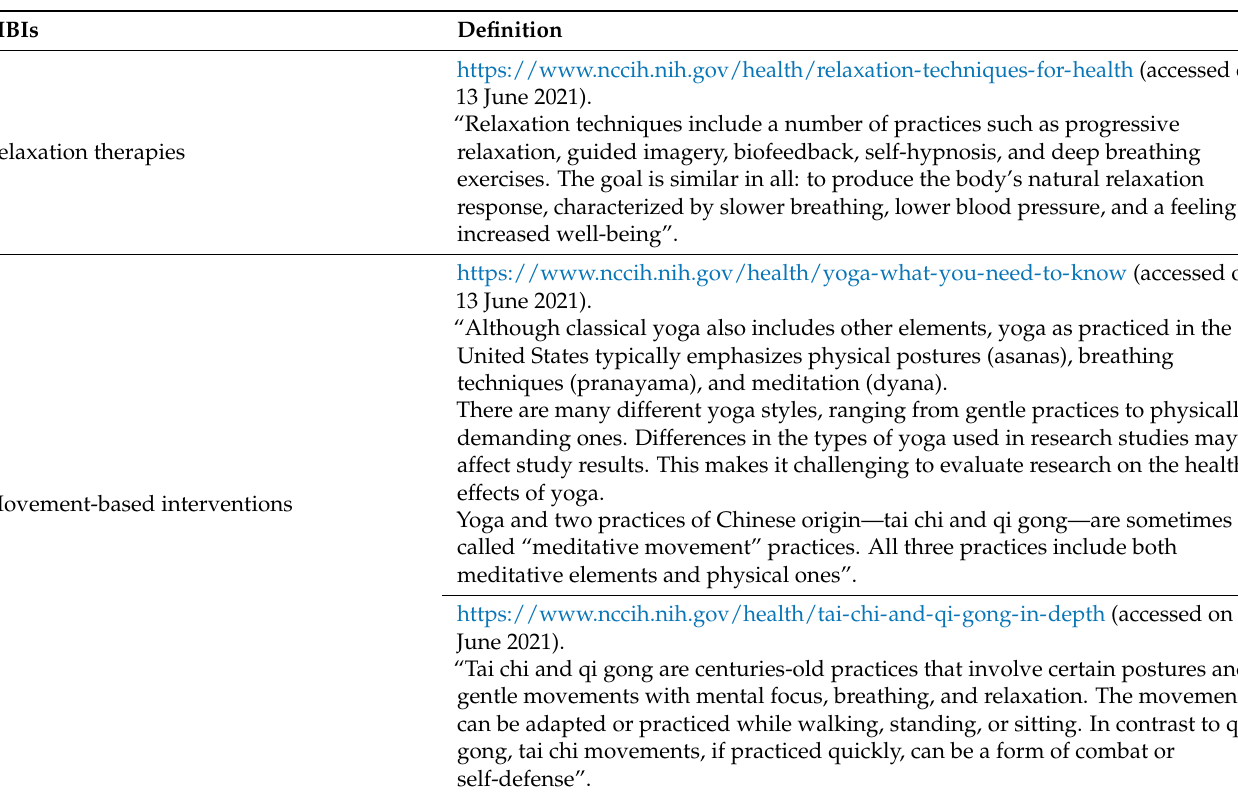
Table A6. Brief descriptions of mind-body interventions used in the included